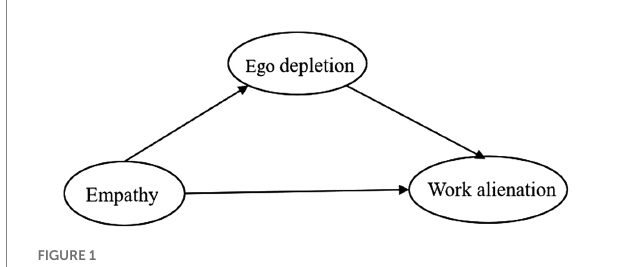
FIGURE 1 Hypothesis model of empathy as a predictor of work alienation mediated by ego